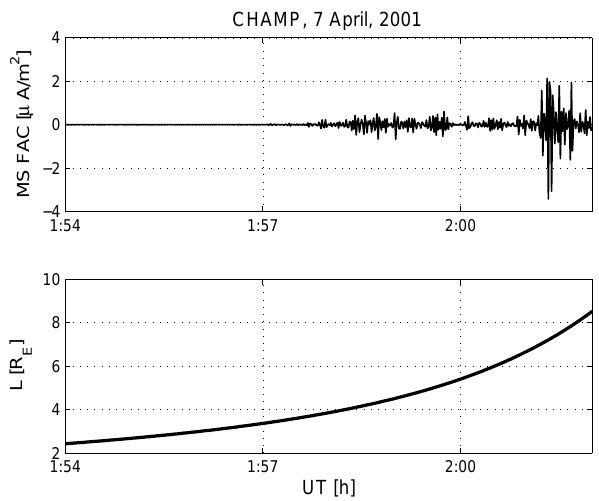
Fig. 1. Example of MSFAC density variation along the orbit. In the bottom panel the L -value of the measurements is